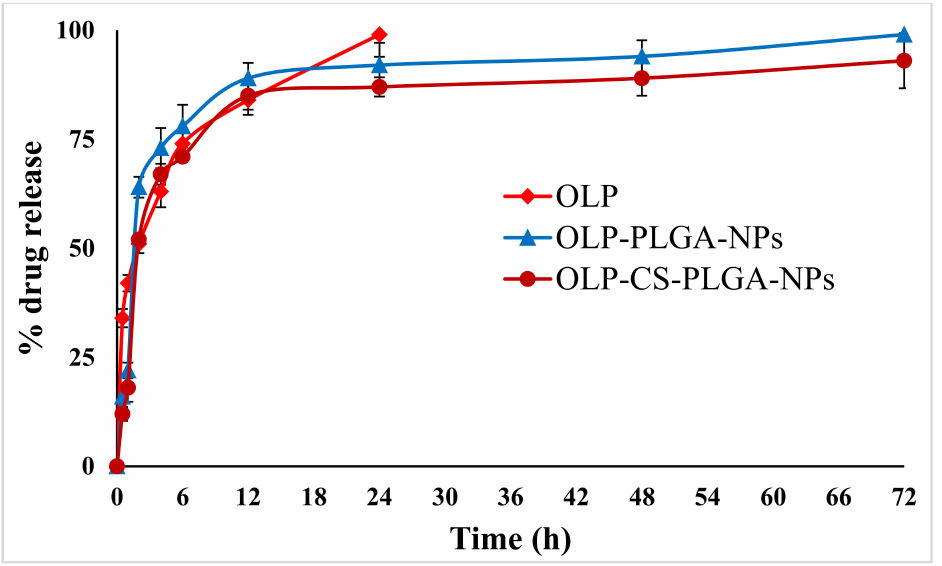
Figure 5. Comparative in vitro release profile of OLP, OLP-loaded PLGA NPs and OLP-loaded CS-PLGA